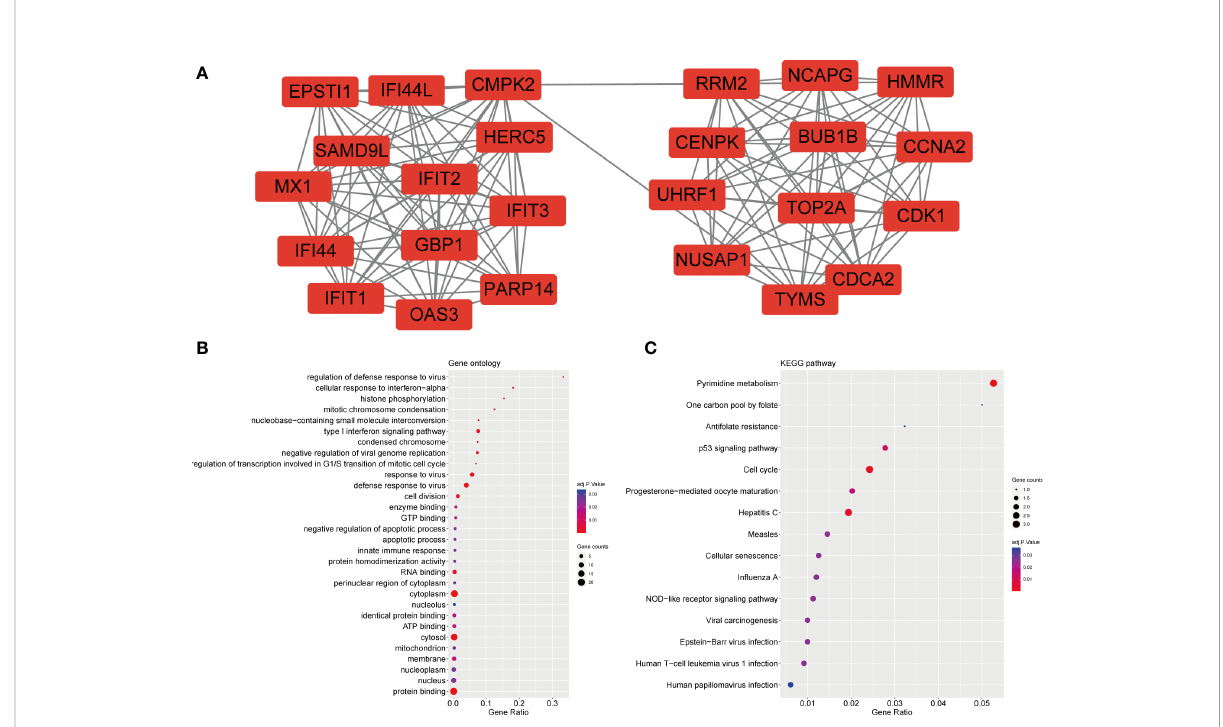
We assessed the diagnostic ef fi cacy of the 12 hub genes by plotting ROC curves. In the COVID-19 dataset, TYMS (AUC:0.952), RRM2(AUC:0.954), CDCA2(AUC:0.946) and TOP2A(AUC:0.958) exhibited good diagnostic ef fi ciency for